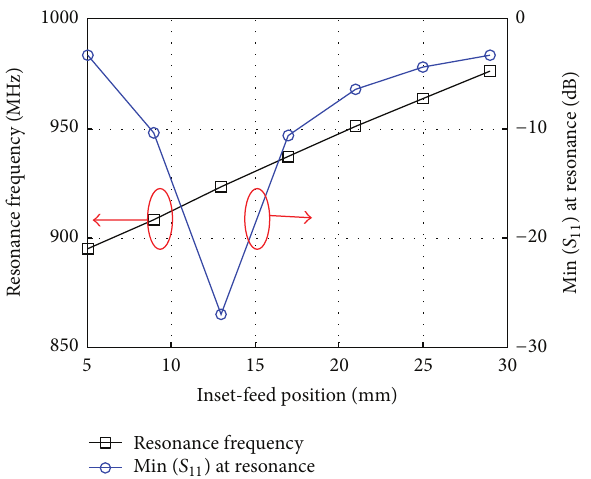
Figure 5: Simulated antenna resonant frequency and minimum reflectioncoefficientwithinthespecifiedbandwidthversusvariation of gap